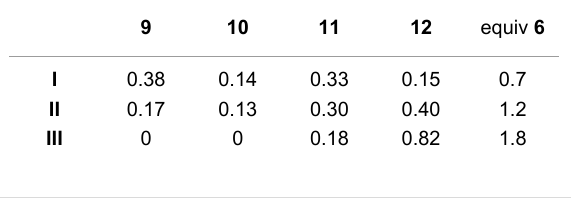
Table 1: Signal integration of 1 H NMR spectra give a quantitative measure of the relative amounts of esters under the conditions speci- fied in Figure 6. Experimental details are given in Supporting Informa- tion File